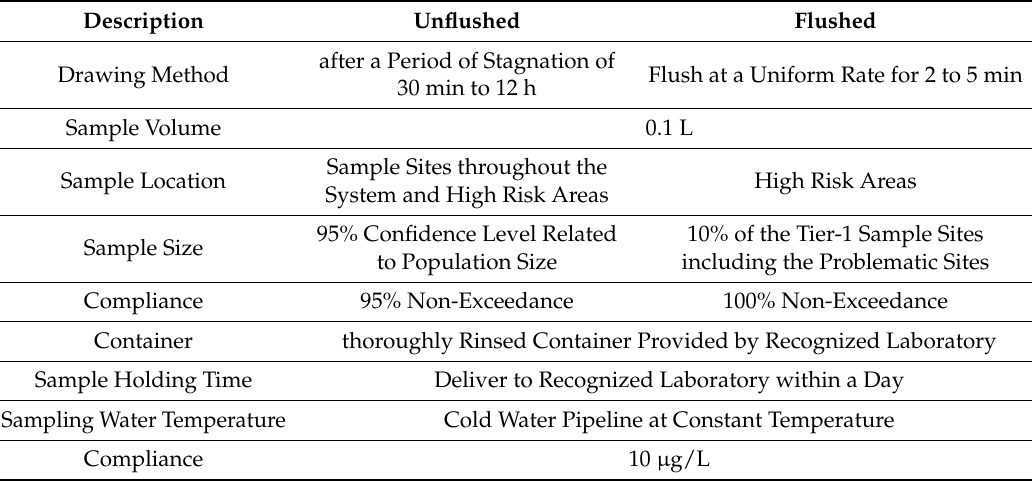
Table 5. Consensus rules for the two tiers of sampling